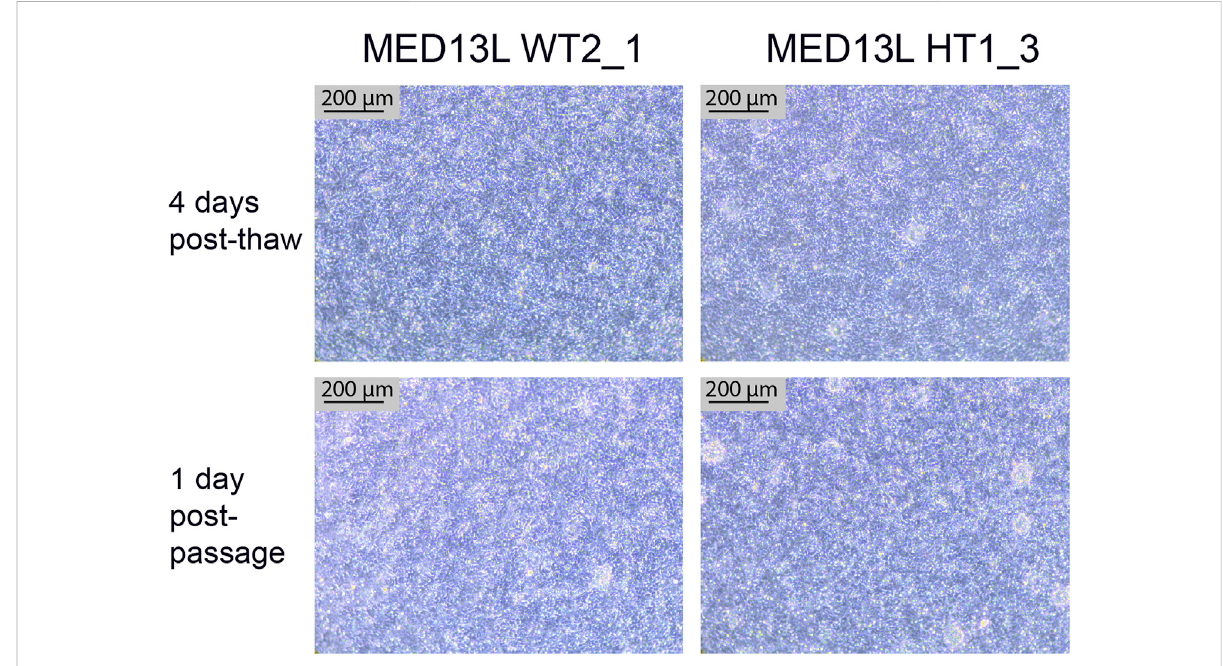
FIGURE 7 Neural Stem Cell QC images. Bright fi eld images of two cell lines from the MED13L gene set (WT2_1, and HT1_3), which both display typical morphology. The top images are from 4 days after the QC thaw (just before passage), and the bottom two images are from the following day, 1 day after a 1:1 passage. Scale bar, 200 μ m